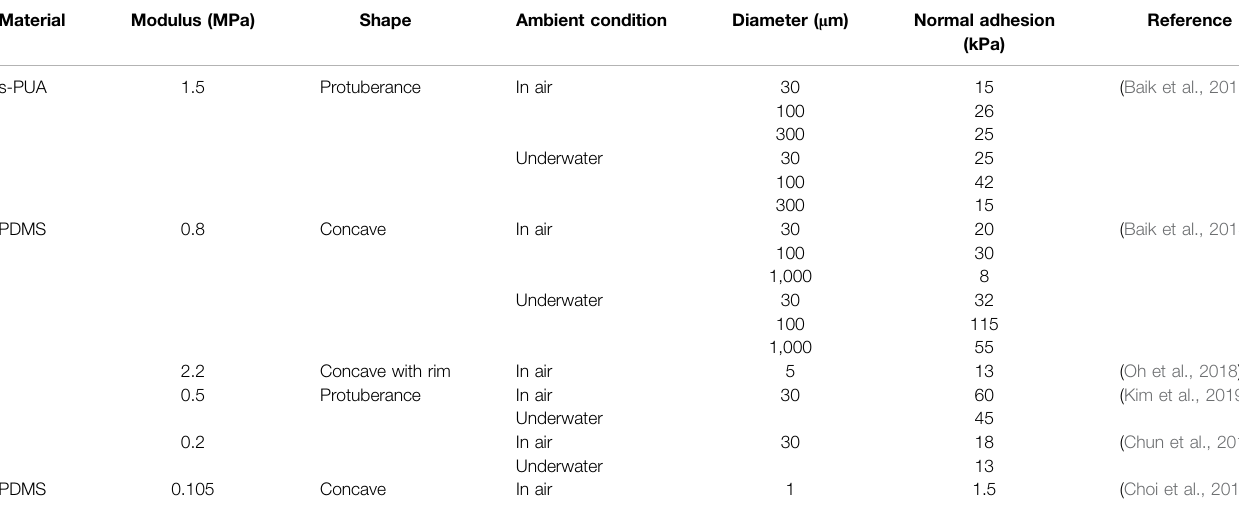
TABLE 2 | Crater-Enabled Soft dry